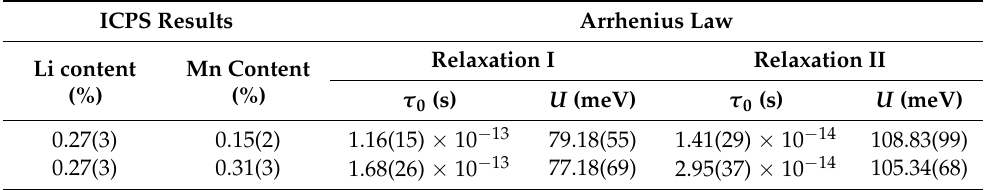
Table 1. Li and Mn contents in KTaO 3 single crystals according to ICPS analysis as well as the Arrhenius law relaxation time at infinite temperatures τ 0 and activation energy U for dielectric relaxations observed on